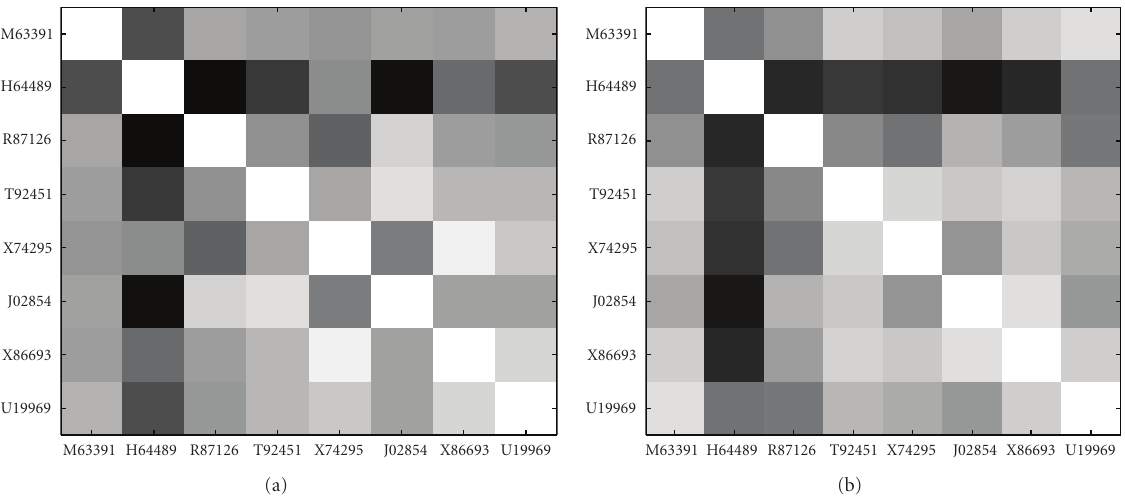
Figure 8: Images of the Pearson correlation coe ffi cient matrices for the eight genes from colon dataset. (a) Normal samples. (b) Disease